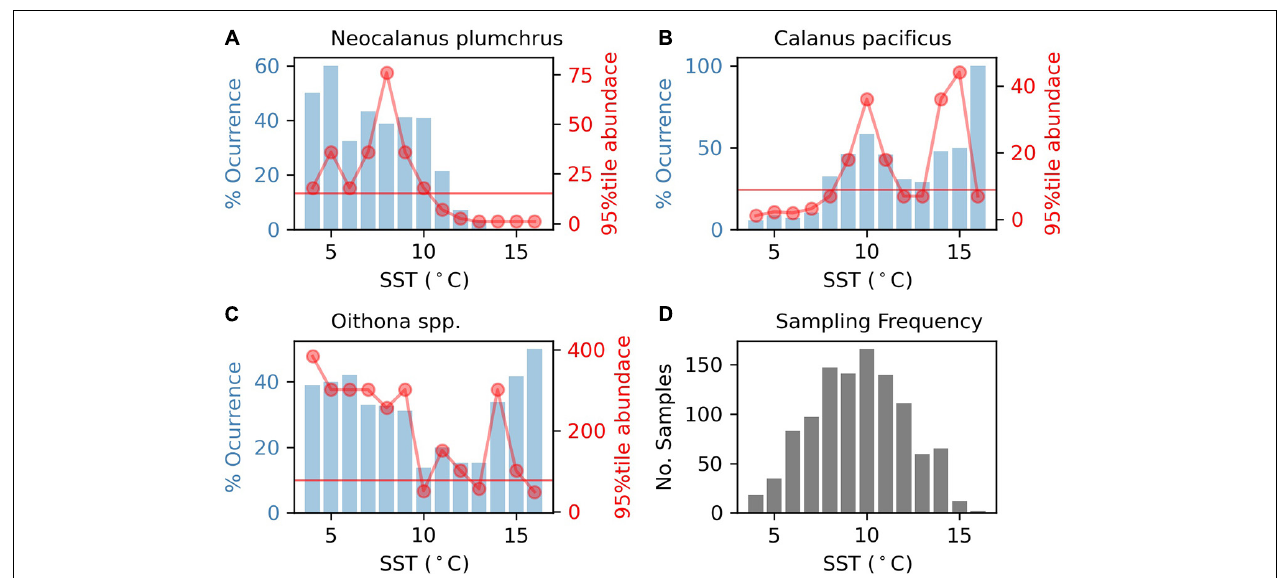
FIGURE 2 | The blue bars represent taxon percent occurrence in samples. Red dots indicate the 95th percentile of taxon abundance. The horizontal line represents the thermal threshold based on the 95th percentile of abundance metric (20% of the maximum value of 95th percentile of abundance metric for the region). Percent occurrence and 95th percentile of abundance for each taxon are from the entire study region and span the entire seasonal period. All data are divided by 1 ◦ C SST (based on MUR-SST) bins. (A) Plot of Neocalanus plumchrus occurrence and abundance. (B) Plot of Calanus pacificus occurrence and abundance. (C) Plot of Oithona spp. occurrence and abundance. (D) Histogram of sample